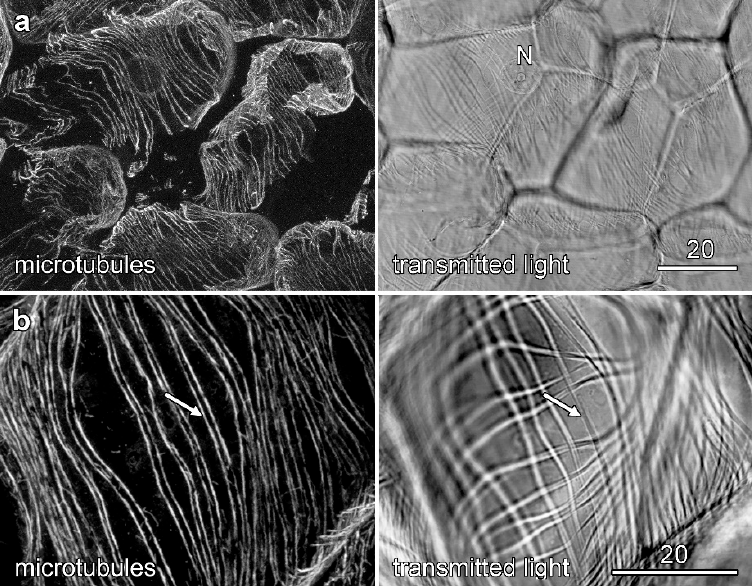
Figure 6. Microtubules and velamen development in Miltoniopsis . Microtubule images (left column) are maximum projections of confocal optical series from early ( a ) and late ( b ) velamen development and are shown alongside concurrent transmitted light images (right column). Labelling is of cells from the inner velamen in vibratome sections. When cell wall ridges first developed ( a ), they were only weakly visible by transmitted light but, being unlignified, were not yet autofluorescent. Microtubules formed strongly bundled, parallel arrays. Later in development, when cell wall ridges were more pronounced ( b ), the immunolabelled microtubules were often paired, running along either side of the cell wall ridges (arrows). Bars in ( a , b ) = 20 µm.